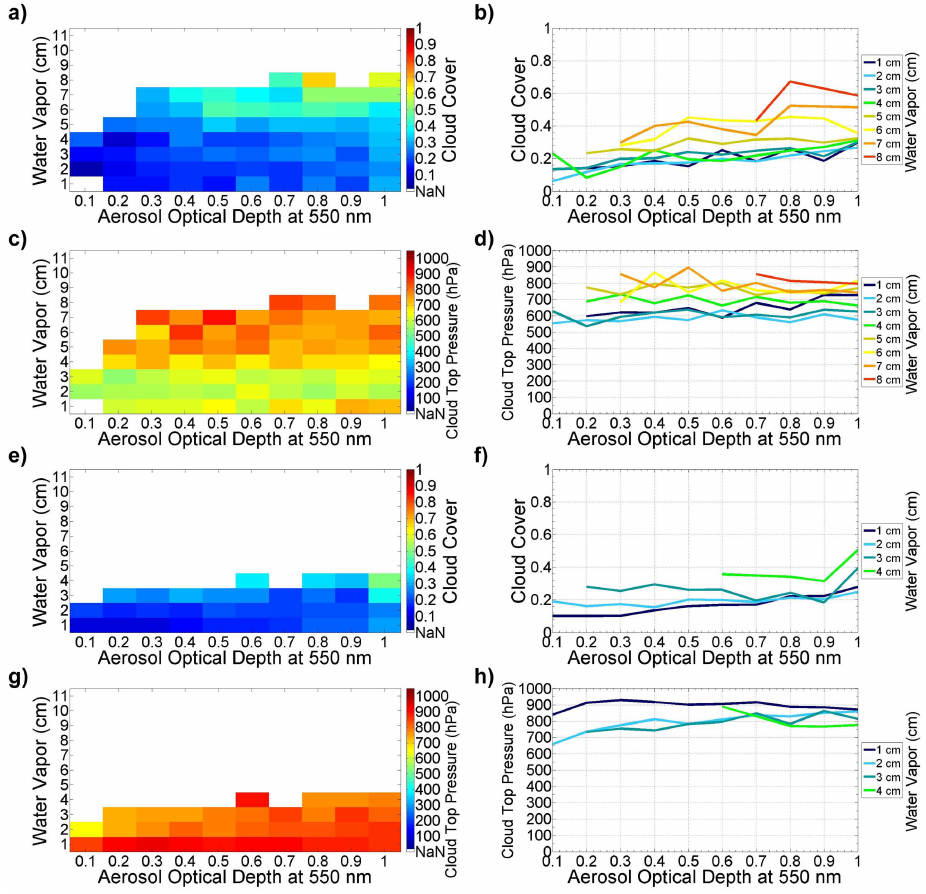
Figure 2. MODIS AQUA data for the Beijing–Tianjin–Hebei (BTH) urban cluster, 2003–2013, AOD-WV-CC (a–b) , AOD-WV-CTP (c–d) for SLP<1008hPa, and AOD-WV-CC (e–f) , AOD-WV-CTP (g–h) for SLP>1017hPa. NaN on the cloud data color bar denotes no values or fewer than six values in this bin. Figures on the left present average CC and CTP values in 1cm WV and 0.1 AOD bins, while figures on the right present results as line graphs. The CC–AOD line graphs and CTP–AOD relations were calculated by averaging CC and CTP within 0.1 AOD bins for several 1cm WV